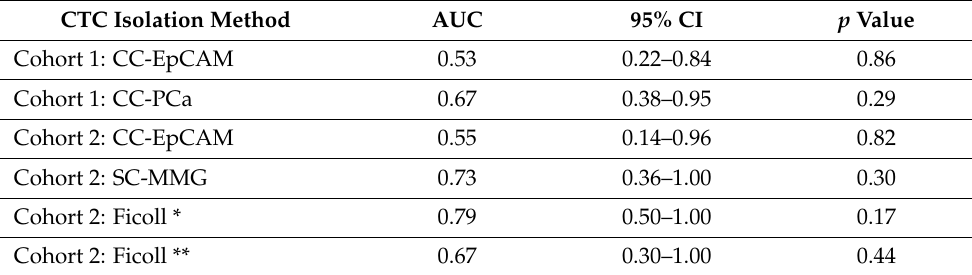
Table 2. Receiver operating characteristic curves for the CTC isolation methods.